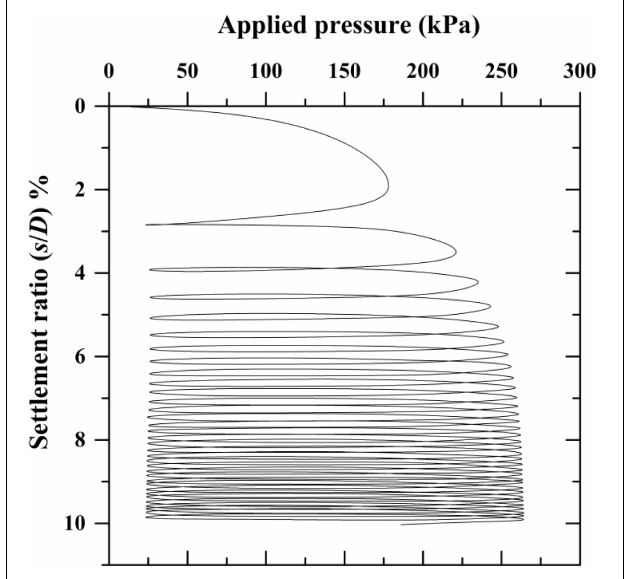
FIGURE 5 | Percentage reduction in settlement for different reinforced